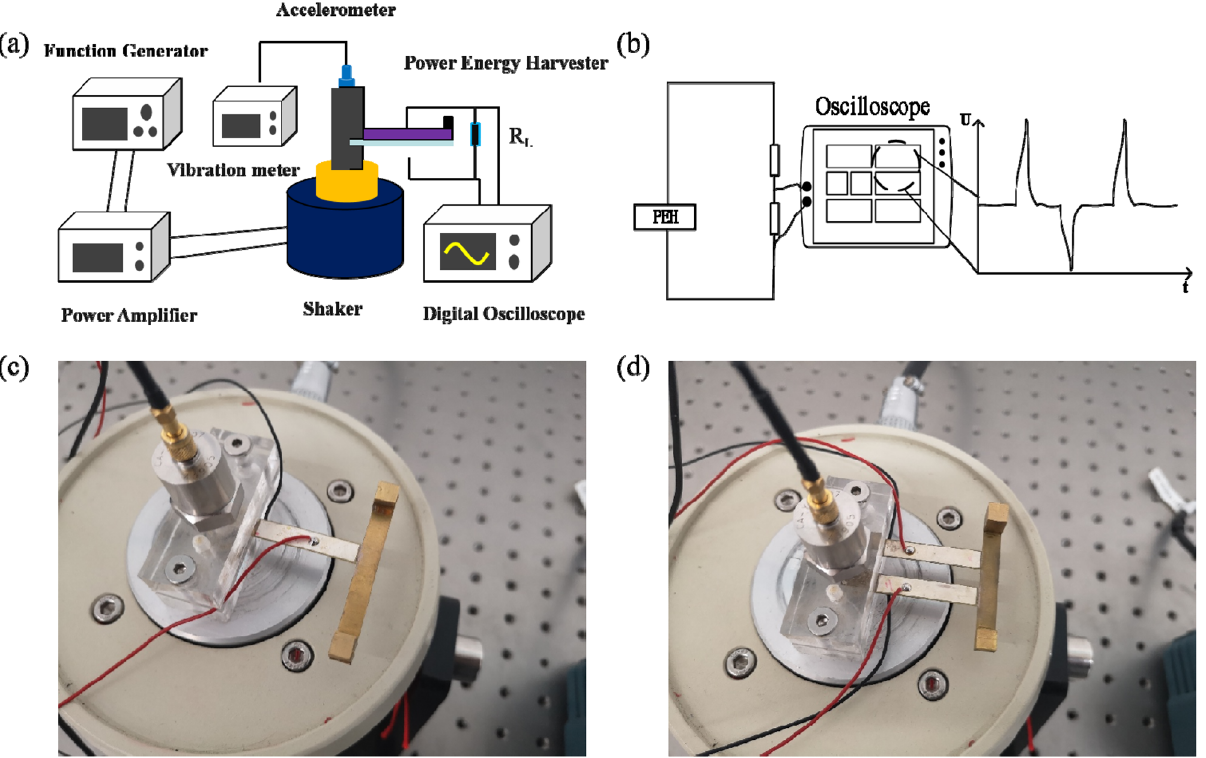
Figure 8. Schematic diagram ( a ). Power measurement circuit ( b ). The vibration component prototypes of PEHSCB ( c ) and PEHDCB ( d ).